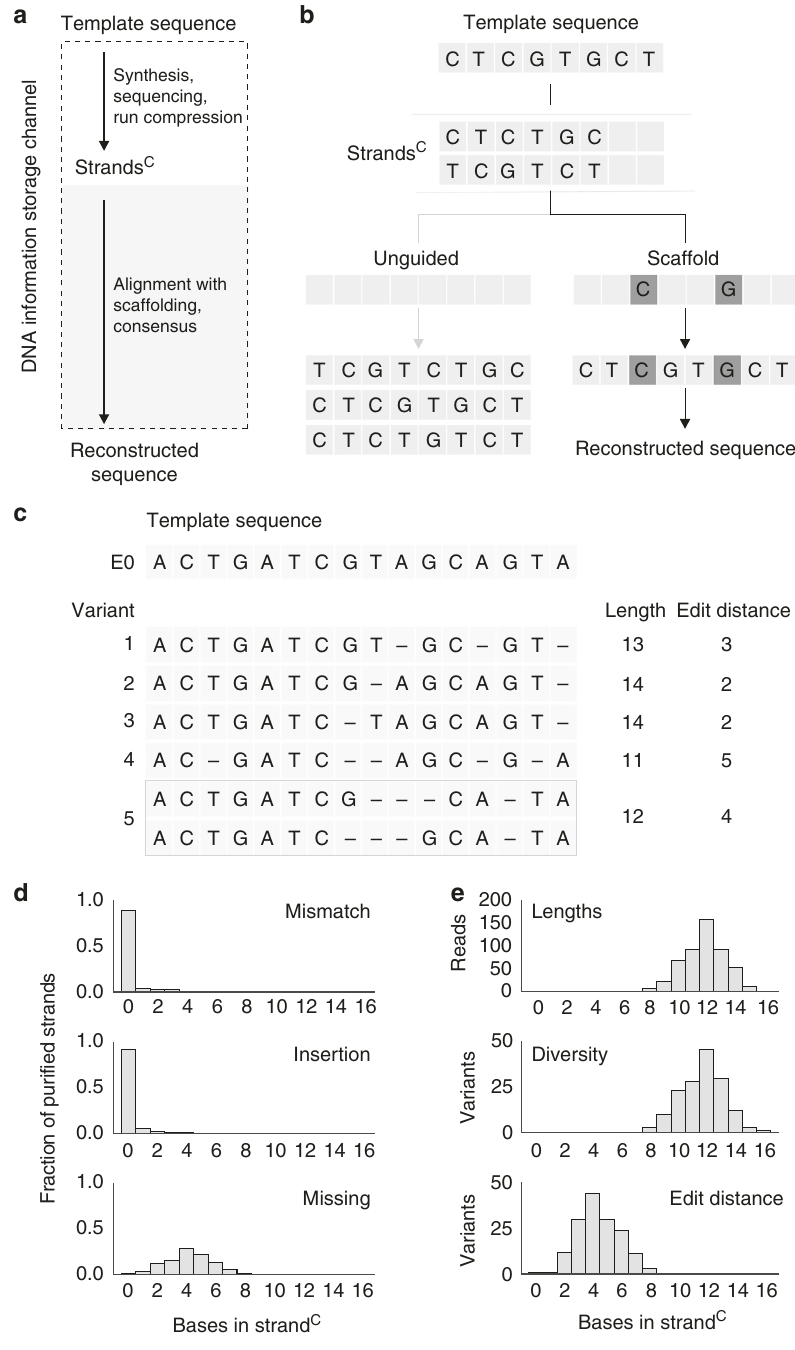
Fig. 3 Coded strand architecture for sequence reconstruction. a A DNA information storage channel. Data are converted to template sequences, synthesized (yielding strands R ), and can be stored in vitro. Retrieval starts with sequencing, then transitions of non-identical nucleotides are extracted in silico to form strands C . Data retrieval occurs when the template sequence and reconstructed sequence are equivalent. Errors that occur in the synthesis and sequencing steps can be modeled as a communications channel. b A coded strand architecture, “ scaffold ” , enables data retrieval from strands C that are missing nucleotides, whereas an “ unguided ” reconstruction results in multiple possible solutions. Synchronization nucleotides (dark gray boxes) localize errors to yield a single reconstructed sequence. c A 16-base transition sequence, E0, is synthesized and sequenced with Illumina. Examples of diverse strands C produced by synthesis of E0. Strands C are aligned, by Needleman – Wunsch, to the template. Ambiguous alignments can exist depending on the location and number of missing nucleotides within a strand C . d Error analysis for puri fi ed strands of E0. Synthesized strands were puri fi ed in silico, by fi ltering for strands R between 32 and 48 bases in length, and corresponding strands C were aligned by Needleman – Wunsch to the E0 template. For each alignment, the number of mismatches, insertions, and missing nucleotides were tabulated. e Evaluating the diversity of synthesized strands. The number of sequencing reads for each length of strand C was tabulated. Diversity was evaluated as the number of unique variants at each length of strand C and the Levenshtein edit distance was computed with respect to the E0 template. The set of 802 puri fi ed strands contains two perfect strands. Source data